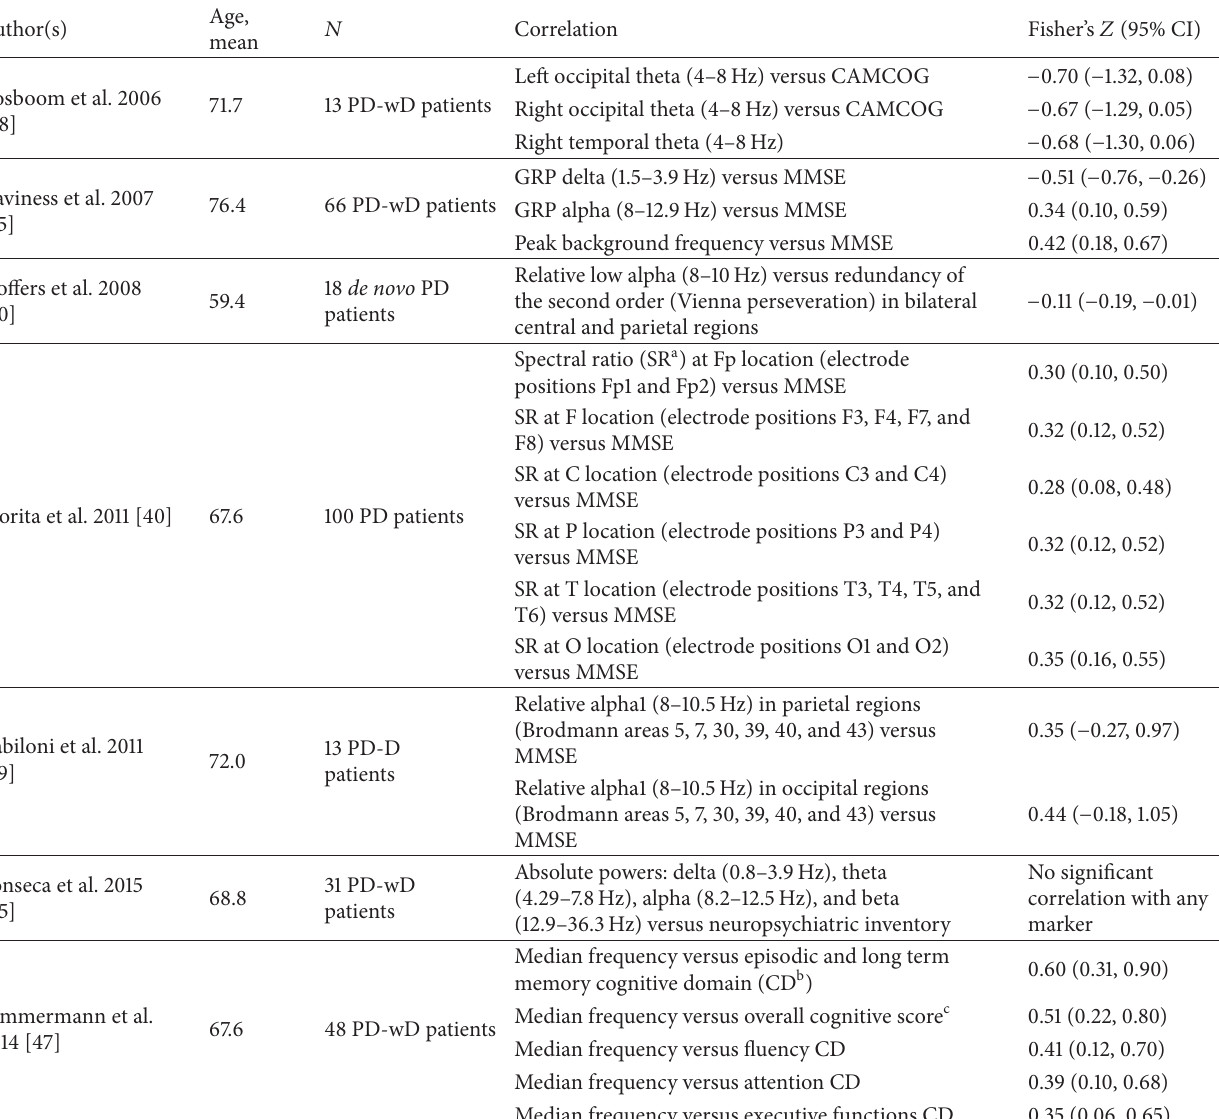
Table 3: Markers which significantly correlated with various cognitive assessment tools in